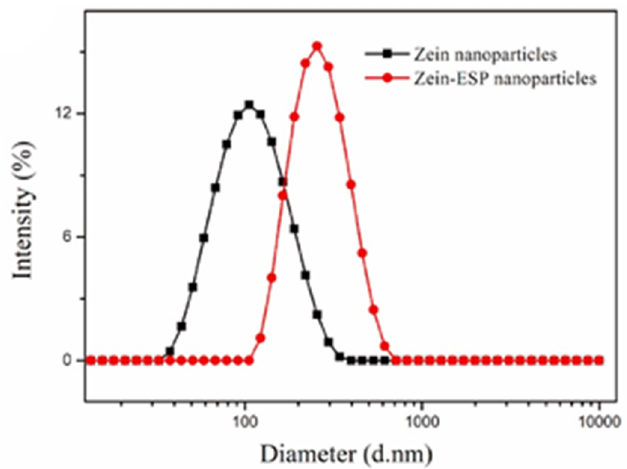
Figure 2. Particle size distribution of zein and zein ethanol-soluble polysaccharide NPs measured by DLS. Adapted with permission from [56]. Copyright (2022) Elsevier.